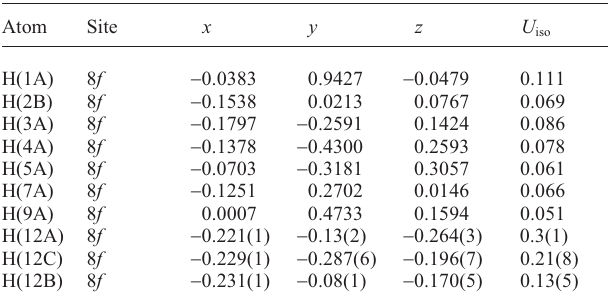
Table 2. Atomic coordinates and displacement parameters (in Å 2 )